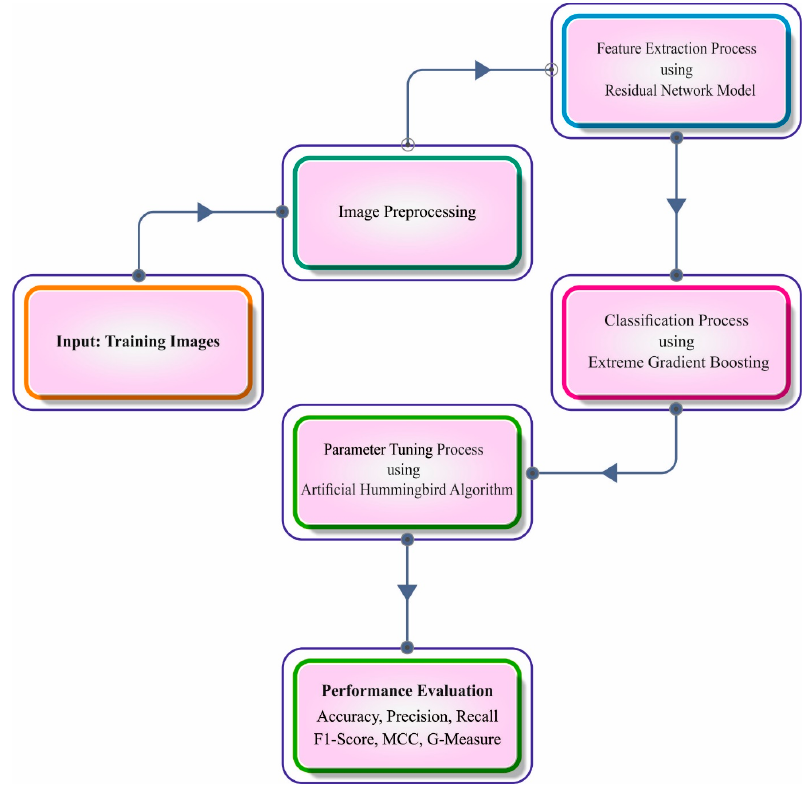
Figure 1. Overall working process of AHBATL-MNC system.